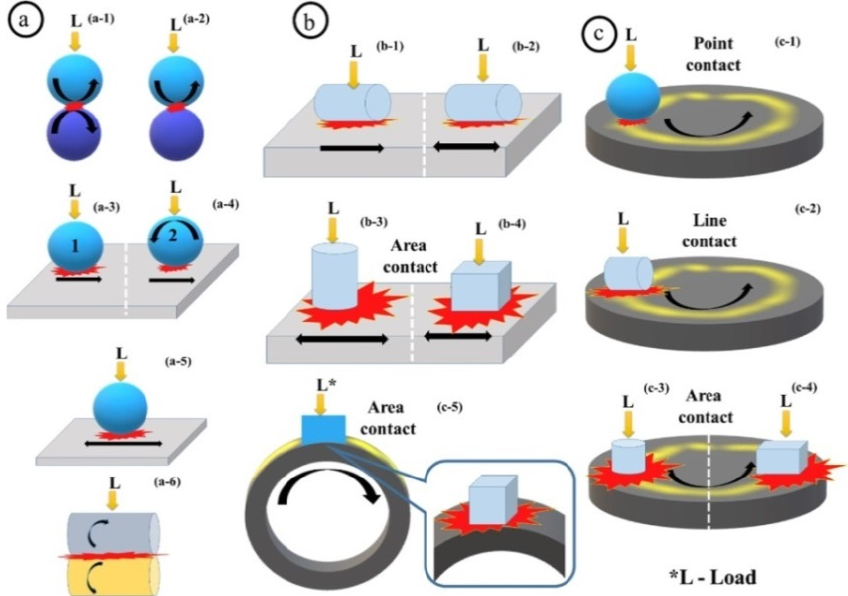
Figure 3. Various tribo-configurations and tribo-contacts: point contact ( a-1 to a-5 and c-1 ), line contacts ( a-6 , b-1 and c-2 ) and area contacts ( b-2 , c-3 and c-4 ). Rotary motion ( a-1 , a-2 , a-4 , a-6 , c-1 , c-2 , c-3 , c-4 and c-5 ), Reciprocating linear motion ( a-5 , b-2 , b-3 , b-4 ), linear forward motion ( a-3 , a-4 and b-1 ). Figure is reproduced with permission from reference [4].